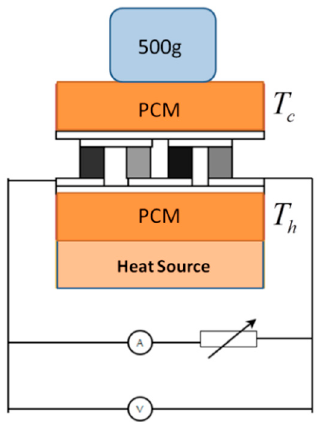
Figure 3. Schematic diagram of experimental device.